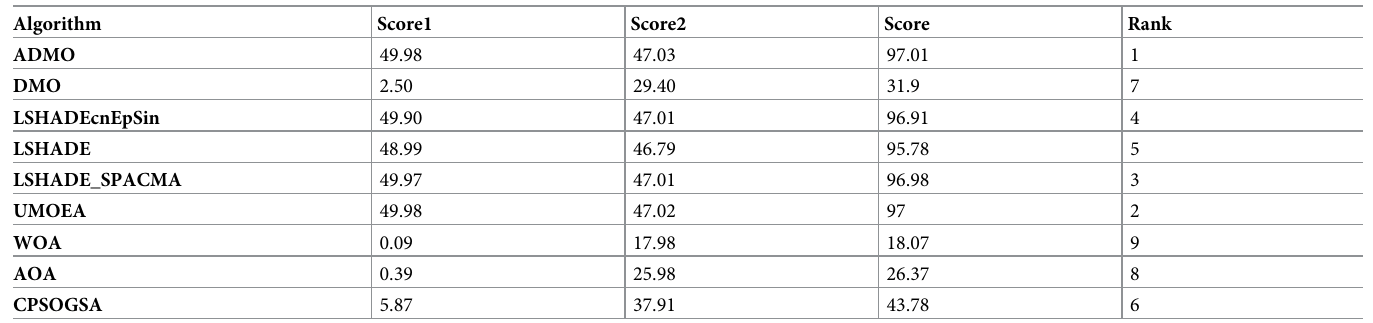
Table 14. Ranking based on scoring format defined in CEC 2017 technical report. Algorithm